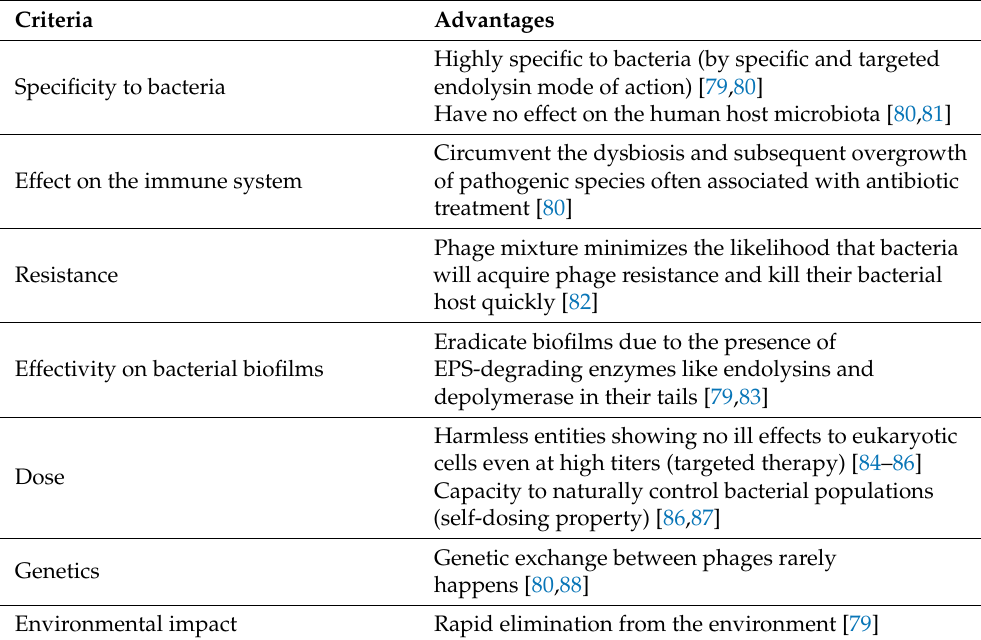
Table 1. Main advantages of bacteriophages for infections